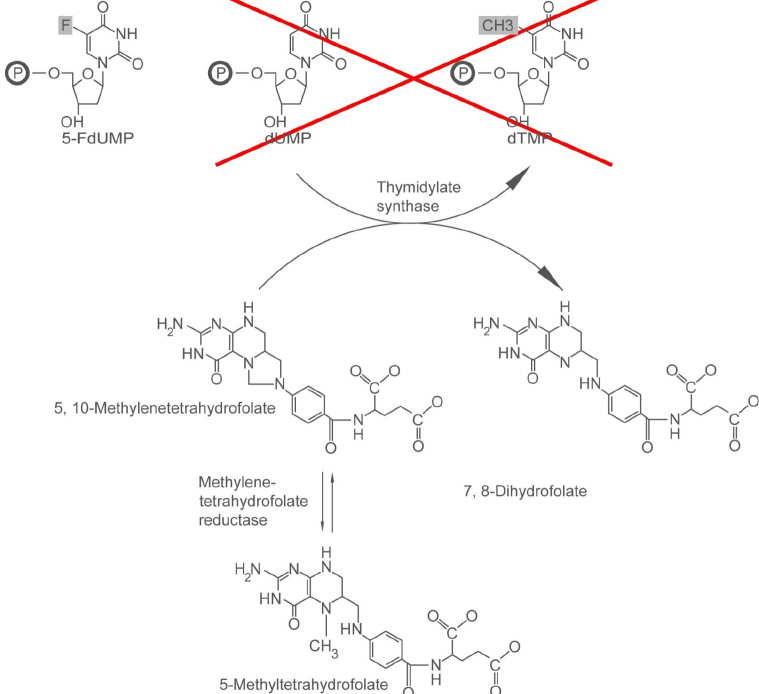
Scheme 2. Activities of thymidylate synthase and methylene tetrahydrofolate reductase. Thymidylate synthase converts dUTP to dTMP, in the presence of 5,10-methylene-THF. 5-FdUMP competes with dUMP, blocking dTMP synthesis. Methylene tetrahydrofolate reductase reduces 5, 10-methylene-THF levels by converting it to 5-methyltetrahydrofolate.